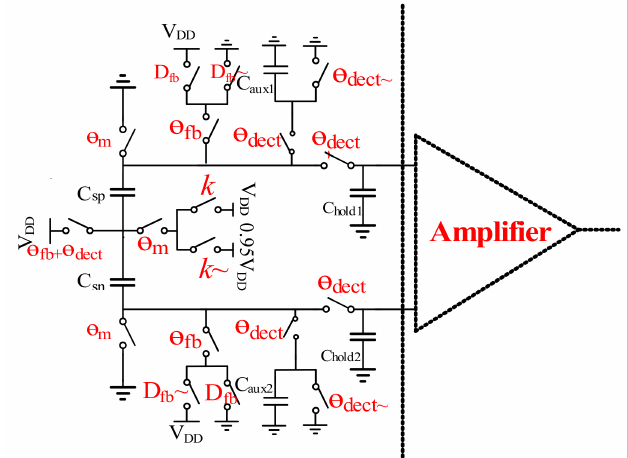
Figure 7. Topology of the C-V switched capacitors.